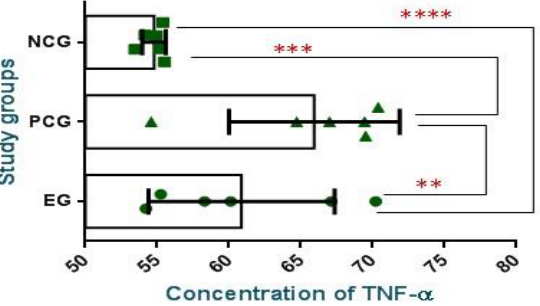
Figure 3. Total results of TNF-α among the experime- ntal groups and the time points . (**), (***), and (****) referred to significant differences between groups as P≤0.01, P<0.001 and P<0.0001